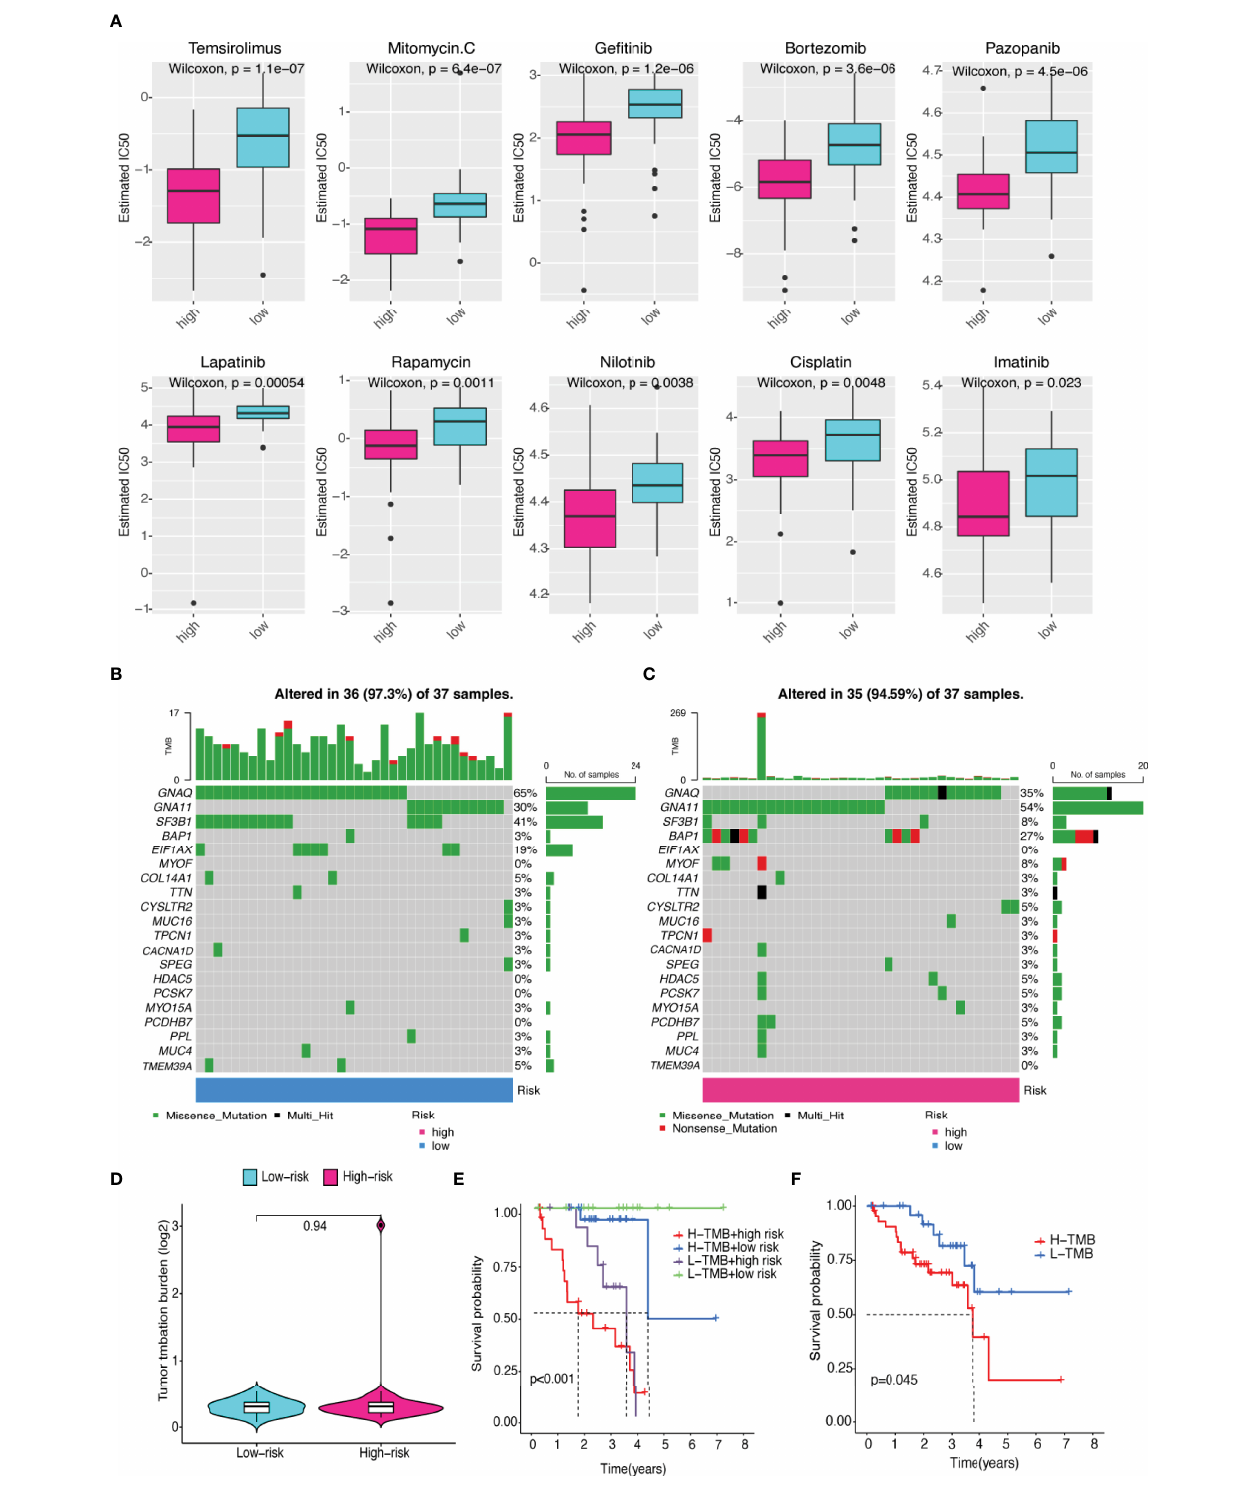
FIGURE 11 | Differences in sensitivity of chemotherapeutic drugs and TMB. (A) The IC50 levels of two prognostic risk groups for ten common chemotherapy drugs. (B, C) Top 20 gene mutations in (B) low- and (C) high-risk groups. (D) Violin plot of TMB in UM patients between two risk groups. (E) The differences in high- and low-TMB levels between high- and low-risk groups in UM patients. (F) Kaplan – Meier plot of overall survival for UM